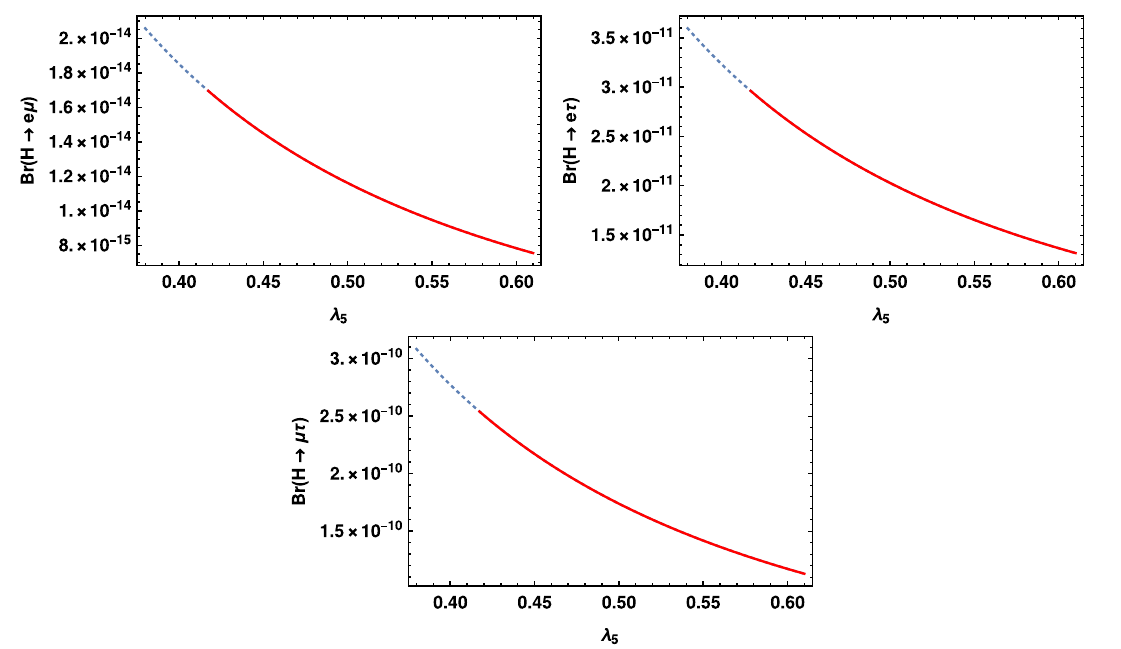
Fig. 7 Plots between Br ( H → (cid:2) α (cid:2) β ) and λ 5 for the case of NO, after applying the constraints from Br ((cid:2) α → (cid:2) β γ) . In these plots, solid lines are allowed and dotted lines are excluded by the constraints due to